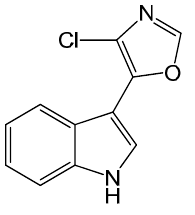
Figure 1. The chemical structure of streptochlorin.